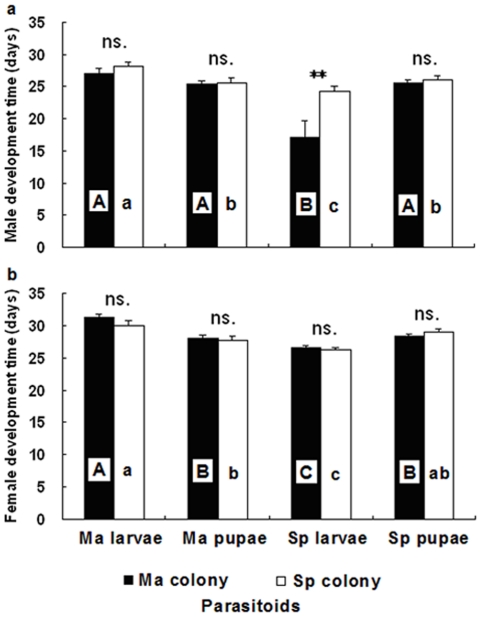
Offspring development time of Sclerodermus harmandi from different culturing systems on two host species and stages: (3a) female offspring, (3b) male offspring.Same alphabets on columns indicate no significant differences (P<0.05). For abbreviations see Figure 1 (Mean±SE, n = 20–24 females in each treatment, ** P<0.01 and ns. P>0.05).